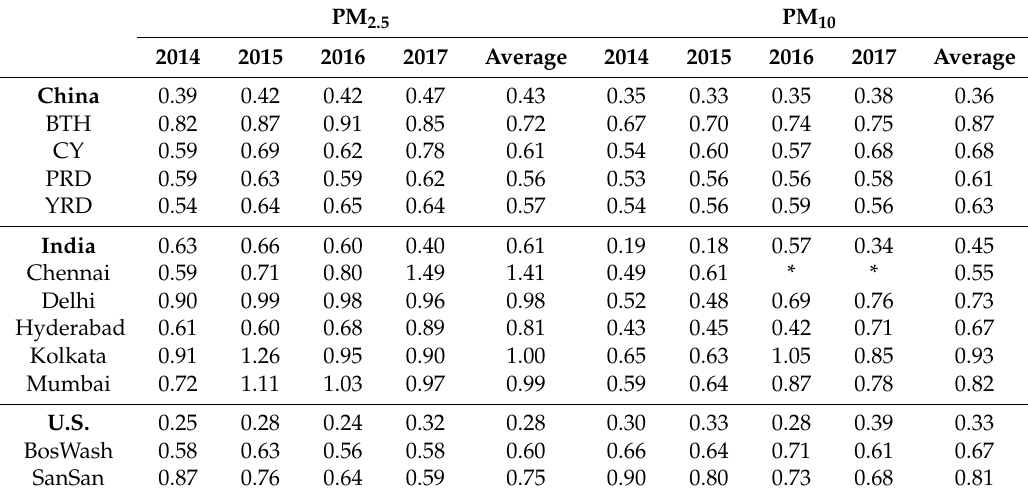
* No data were available.